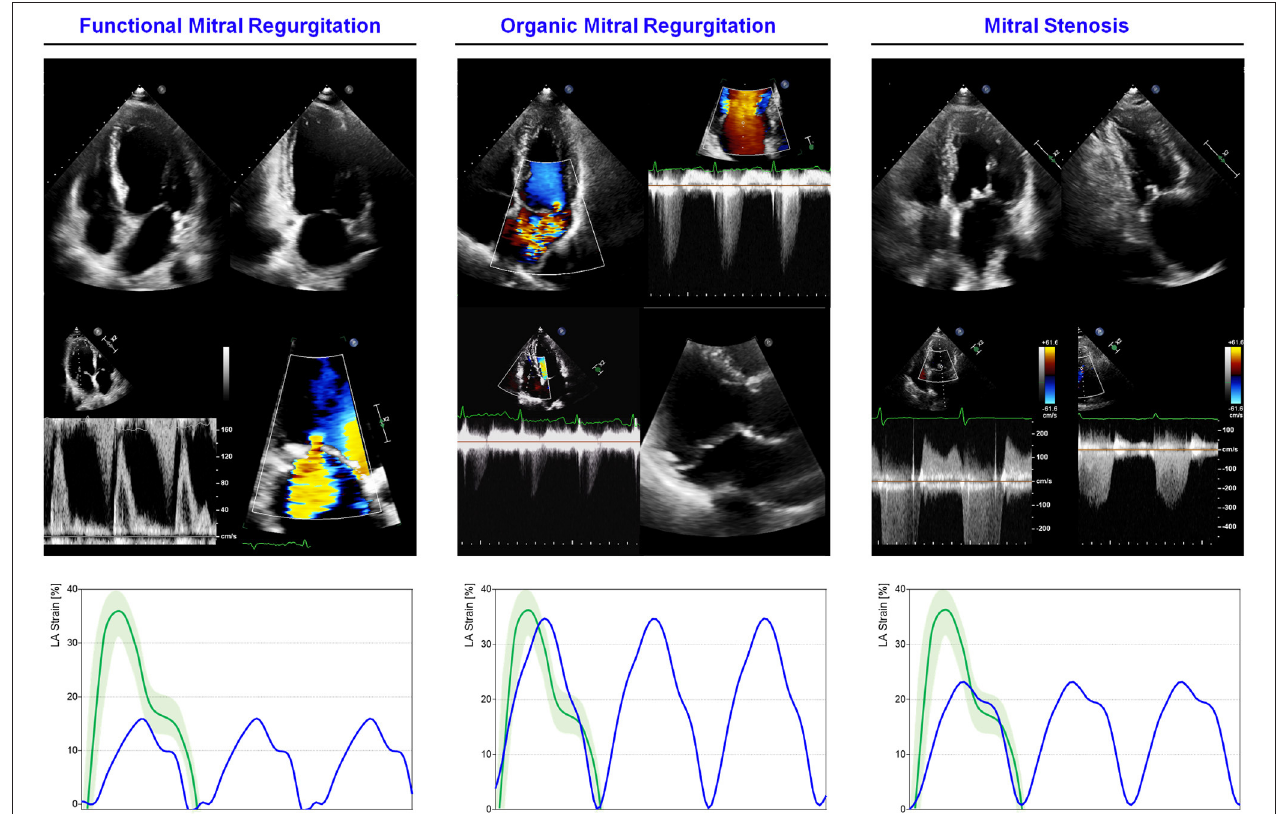
FIGURE 3 | LA mechanics in mitral valve diseases: Examples of echocardiographic images and LA strain are shown for (left) functional MR in HF subjects with severely impaired LA function; (middle) severe MR secondary to bi-leaflet valve prolapse with preserved LA function; (right) moderate mitral stenosis with moderately impaired LA function. Strain traces are cartoons realized with real values of the reported cases. Reference values for LA strain are shown in green. Note that in organic MR, LA is still able to maintain adequate reservoir function differently from functional MR where LA function is exhausted for to the coexistence of HF. Abbreviations as in the